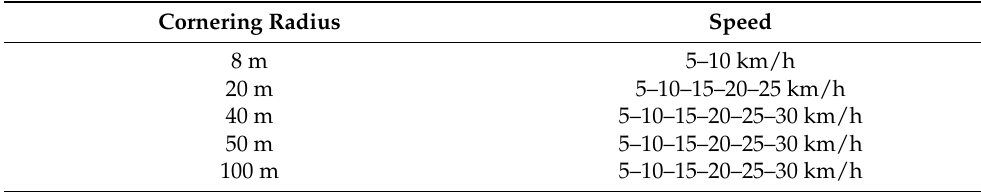
Table 3. Measured points of speed-controlled cornering